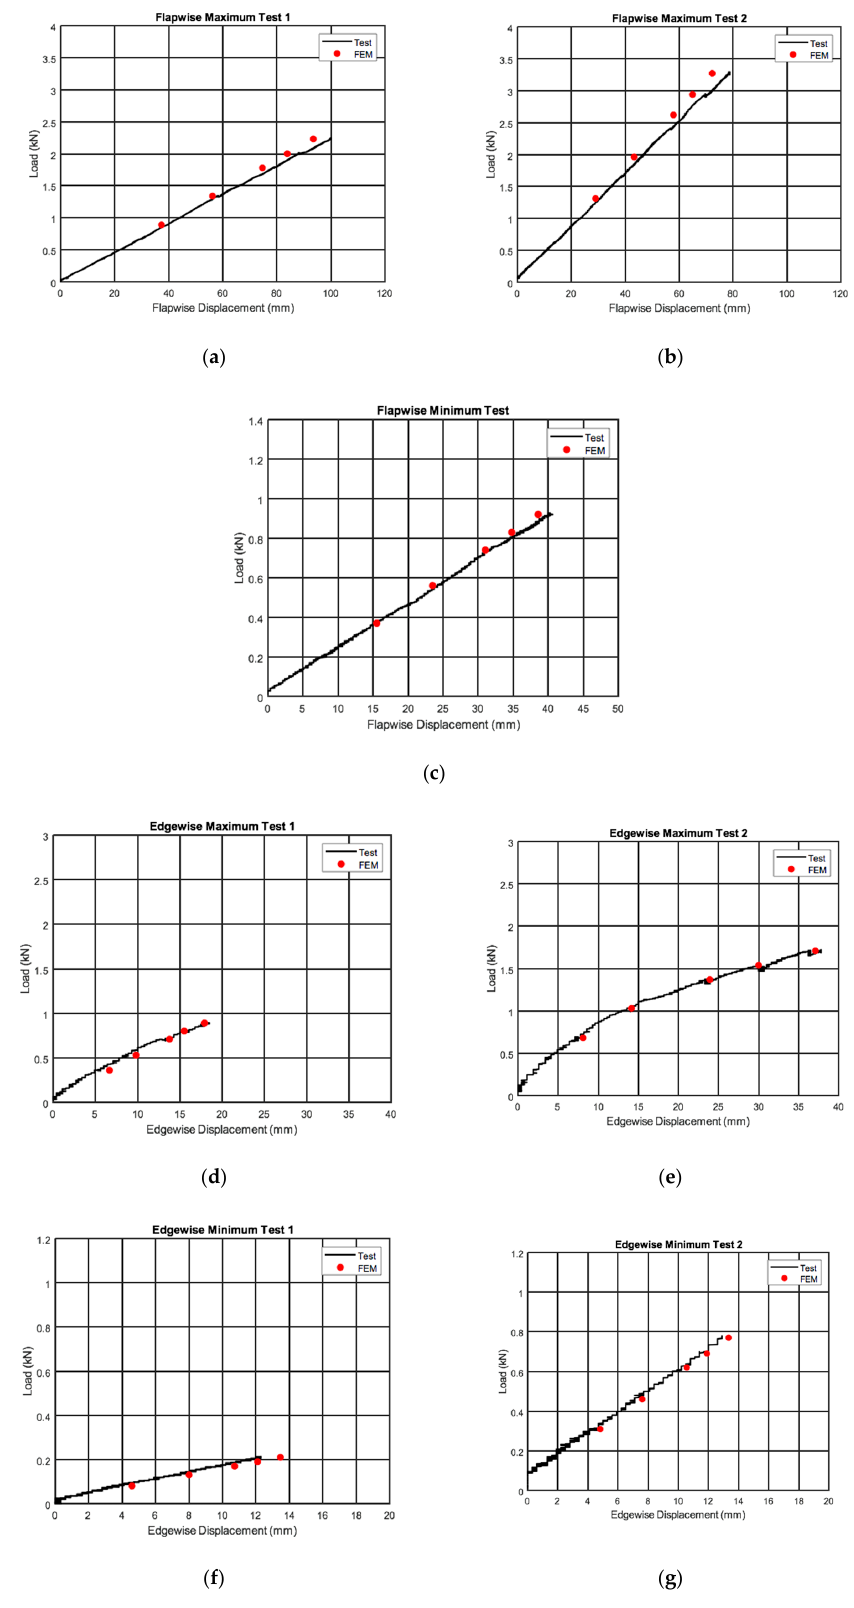
Figure 20. The structural testing and analysis results: ( a ) case 1, ( b ) case 2, ( c ) case 3, ( d ) case 4, ( e ) case 5, ( f ) case 6, and ( g ) case